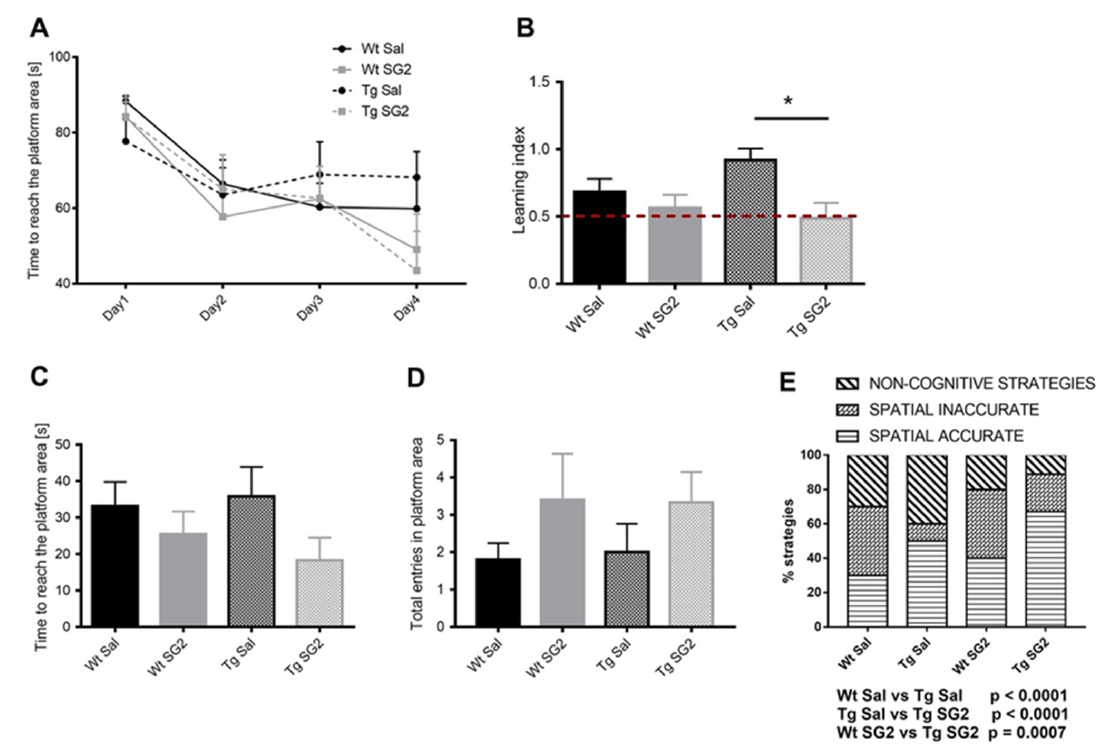
Figure 6. SG2 improves learning ability in the 5xFAD mouse model of AD. ( A ) Analysis of MWM learning curve showed no significant differences between experimental groups (repeated measures ANOVA, Time F (3,105) = 21.57, p < 0.0001, Treatment F (3,35) = 0.3141, p = 0.82, Time × Treatment F (9,105) = 1.553, p = 0.14). ( B ) Learning index analysis demonstrated an improved performance of Tg-SG2 mice compared to Tg-Sal to find the hidden platform. For statistical tests, One-Way ANOVA was used p < 0.02 * ( C ) The time needed to reach the platform area ( C ) and the number of entries in the target area ( D ) were not statistically different between experimental groups. ( E ) The analysis of search strategy showed an increase in spatially targeted strategies in Tg-SG2 mice compared to Tg-Sal mice (Fisher’s test). Data are shown as mean ± SEM. Experimental groups: Wt-Sal, n = 10; Wt-SG2, n = 10; Tg-Sal, n = 10: Tg-SG2, n =